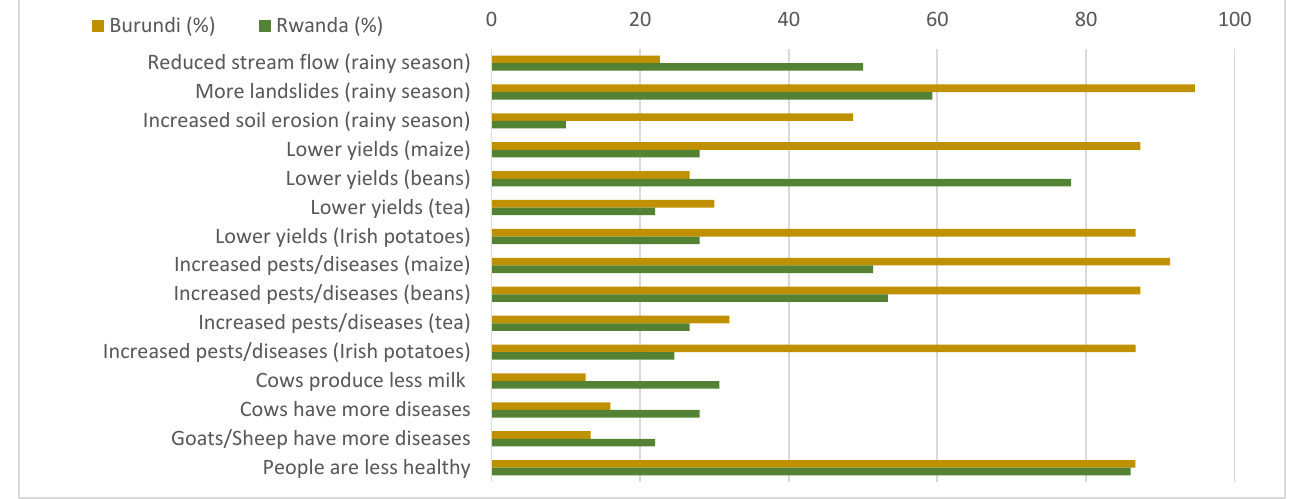
Figure 3. Observed impacts in the biophysical domain regarding the percentage of respondents in each study area (Burundi n = 150, Rwanda n = 150).